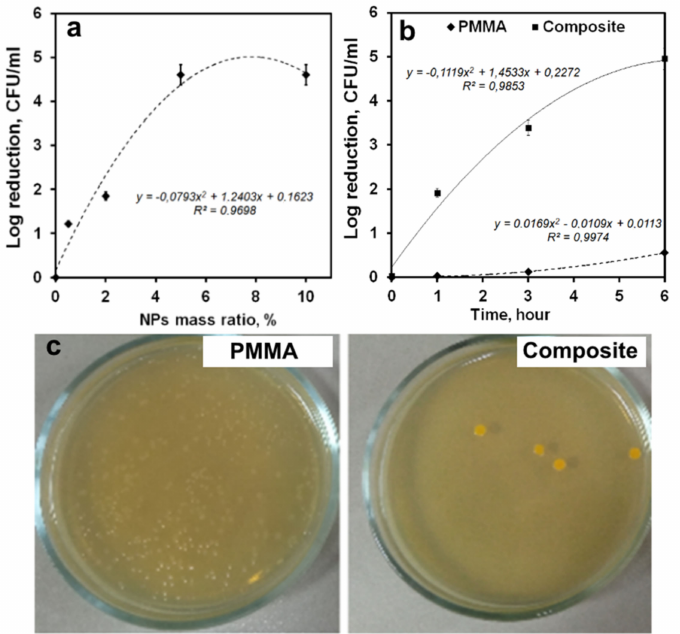
Figure 7. MRSA log reduction after exposure on the surface of the composites with different NP mass ratios ( a ). Time-dependent MRSA log reduction after exposure on the surface of the PMMA and composite, containing 5 wt.% NPs ( b ). Photographs of typical Petri dishes after 3 h exposure of MRSA on the surface of the PMMA and composite, containing 5 wt.% NPs ( c